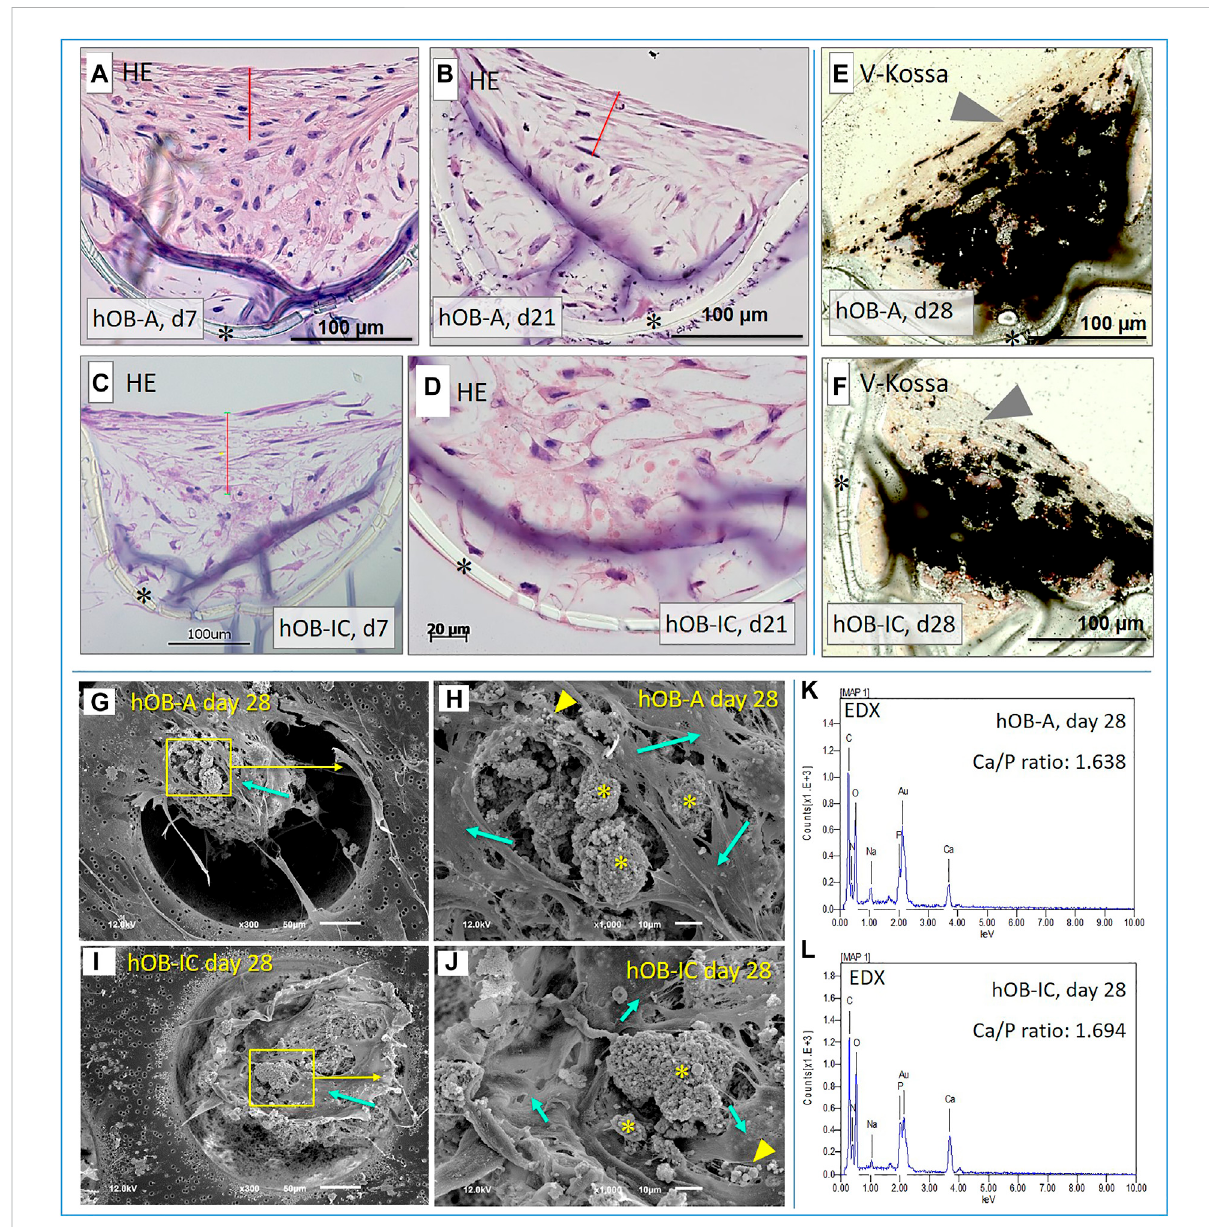
FIGURE 2 Evaluationofthecellaggregationandmatrixmineralizationin3D-microchipcultures. (A − D) Representativeimagesofsagittalresin-embedded sectionsofhOBin3D-microchipculturestainedwithhematoxylinandeosin.Thecellswereculturedinbasiccultureconditions(expansionmedium) and analyzed at days 7 and 21. Red line indicates the horizontally oriented cell layer at the opening of the cavity. Image in (D) shows a high magni fi cation ofthecentral areain thecavity. (E,F) Representative images of sagittal resin-embedded sections of hOBin 3D-microchipculture stained with the Van Kossa method. The cells were cultured for 28 days in 3D-microchips under osteogenic conditions to ensure a signi fi cant mineralization of the extracellular matrix. Black areas in the center of the cavities visualize the calcium deposition and thus areas of mineralization. Arrowheadspointtotheuppernon-mineralizedcelllayerattheopeningofthecavity. (G − J) RepresentativeSEMmicrographsofosteoblastsderived from alveolar (hOB-A) and iliac crest bone (hOB-IC) cultured for 28 days in a 3D-microchip device under osteogenic culture conditions. Stars=Mineralizationnodules,arrowheads=mineralizationvesicles,arrows=cells. (K,L) RepresentativeEDXspectraofhOB-AandhOB-ICcultures after 28 days culture under osteogenic conditions. *Porous membrane of the microchip. Scale bars in (G,I) : 50 μ m; scale bars in (H,J) : 10